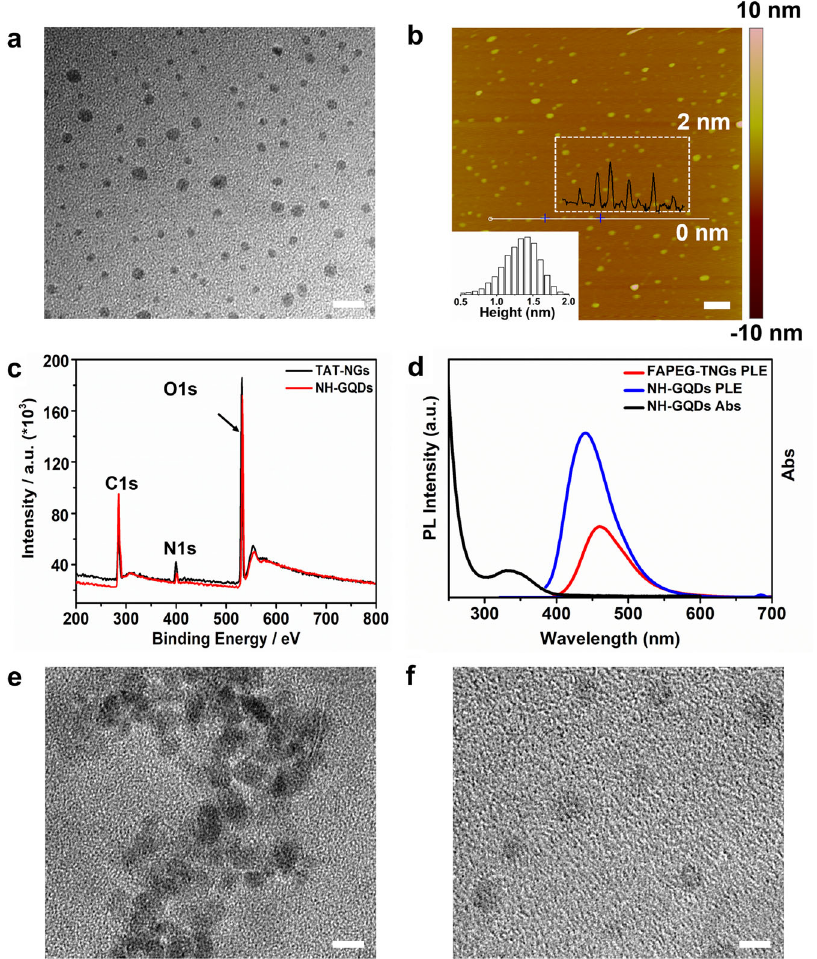
Fig. 2 Characterization of the NH-GQDs derivatives. a HR-TEM image of NH-GQDs. b AFM image of NH-GQDs. c XPS full survey of NH-GQDs and TAT- NGs (10:1). d UV-Vis of NH-GQDs and PL spectra of NH-GQDs and FAPEG-TNGs. e HR-TEM images of TAT-NGs (10:1). f HR-TEM images of FAPEG- TNGs (scale bar of HR-TEM images, 10 nm; AFM image, 500